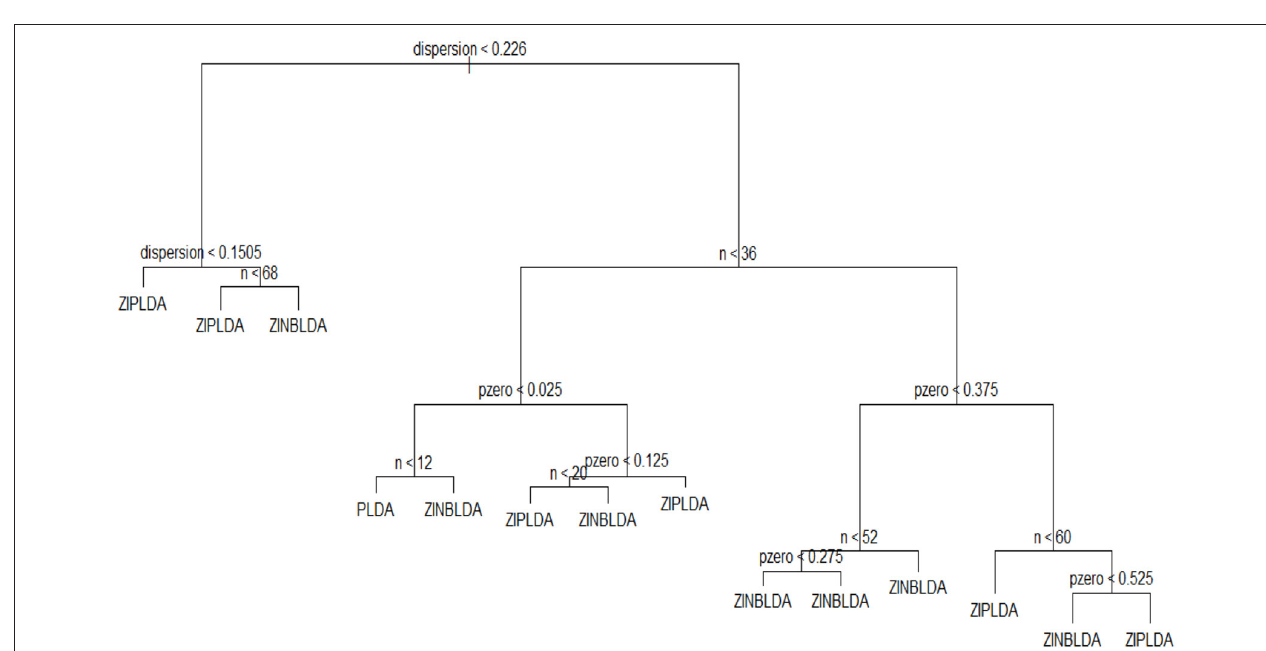
FIGURE 7 | The decision tree model used to choose an optimal